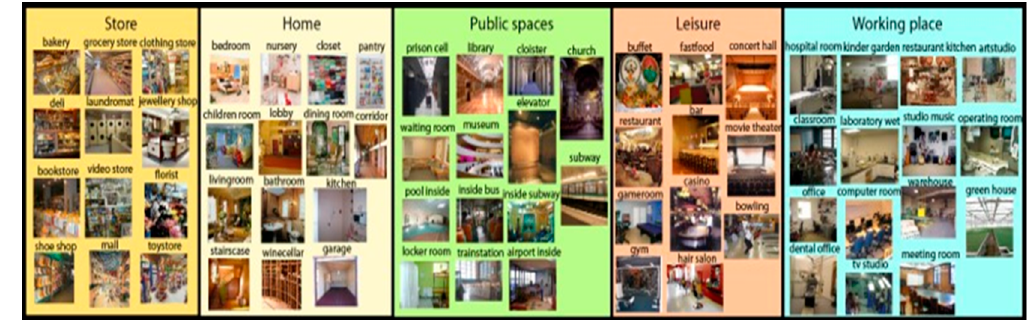
Figure 6. Indoor Scene Recognition dataset images and labels [18].